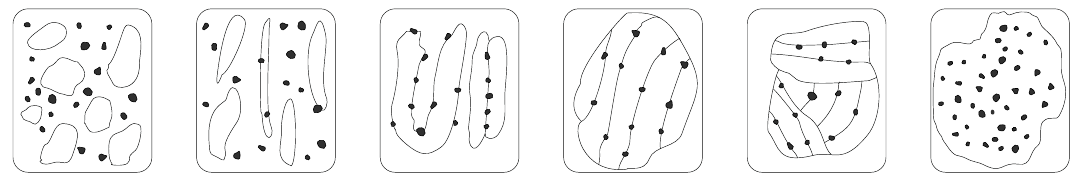
Figure 2. Schematic formation of composite powder during high energy ball milling (based on